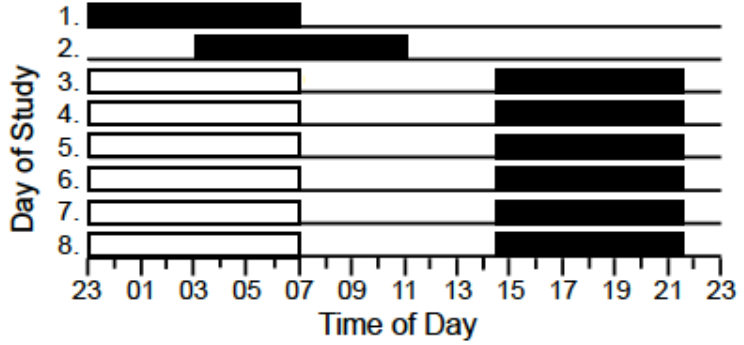
Figure 1. Illustration of the study design. Black horizontal bars indicate sleep opportunities. White horizontal bars indicate simulated work periods. Y -axis: “Day of Study”. X -axis: “Time of Day”.